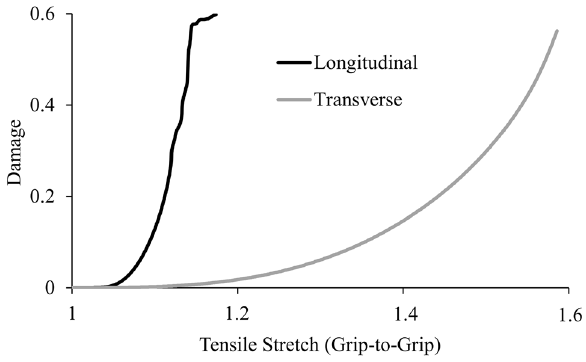
Figure 3. Maximum damage in the tear region of two representative